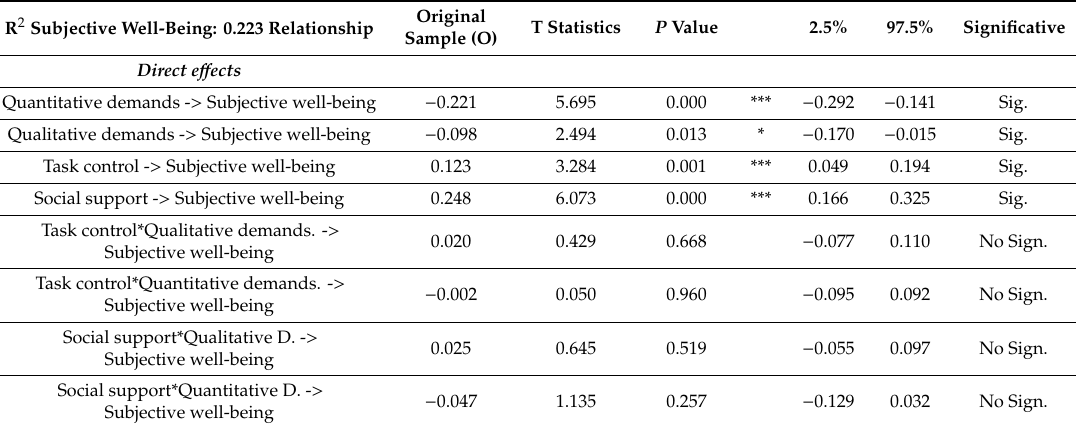
Table 3. Structural Model 1 (Bu ff er e ff